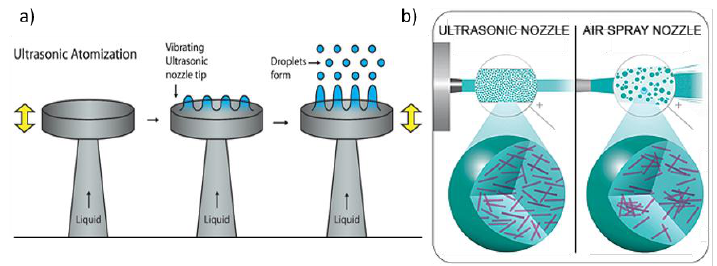
Figure 1. ( a ) The process of ultrasonic atomization of the coating ink at the spray